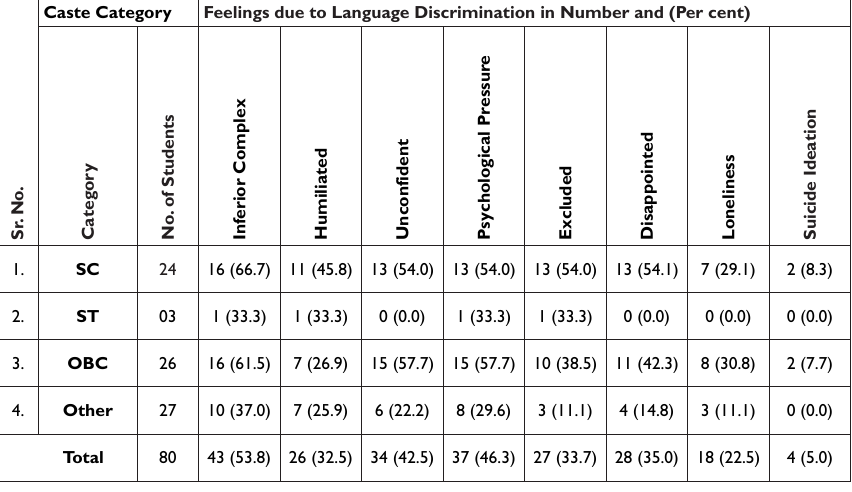
Table 3: Language discrimination inside and outside the classroom and caste